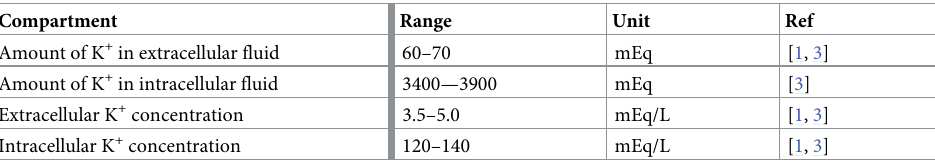
Table 3. Normal ranges for K + concentration and